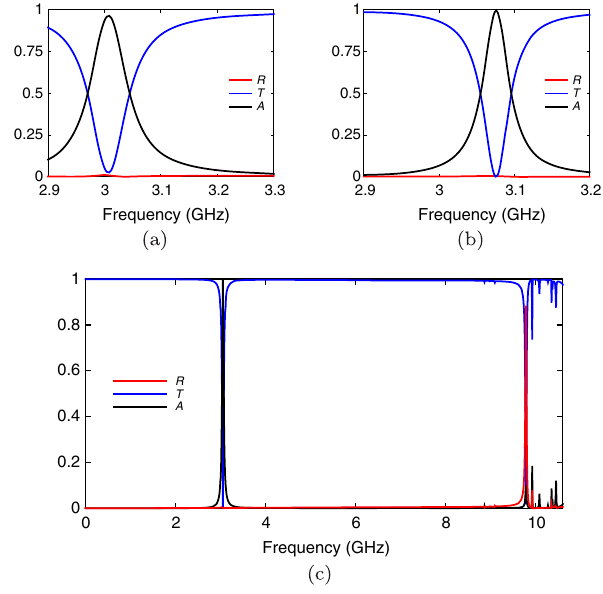
FIG. 6. Simulated power reflection R , transmission T , and absorption A coefficients for infinite arrays of (a) single- and (b) double-turn helical inclusions. (c) Response of the double- turn helix array in a wide frequency